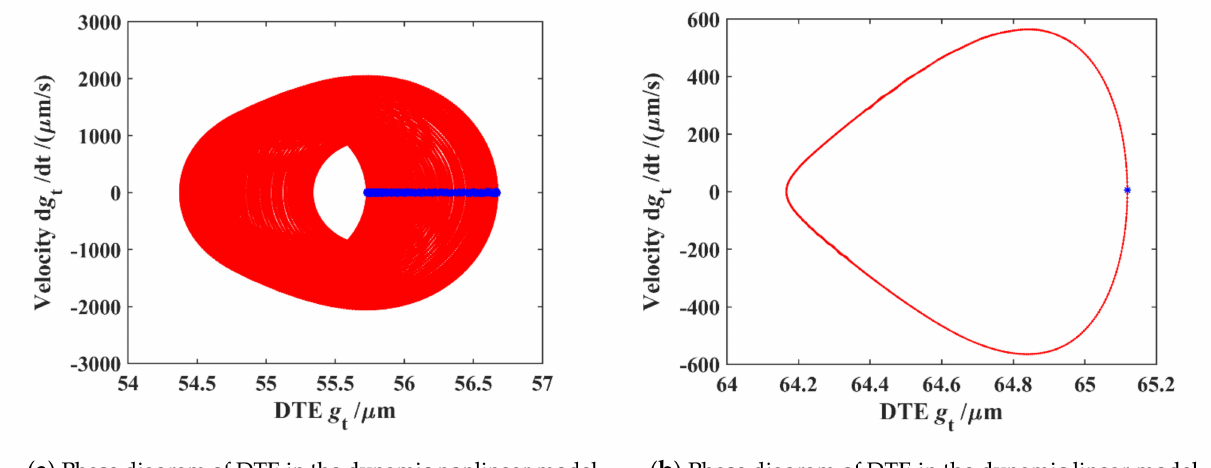
Figure 8. Phase diagram of DTE